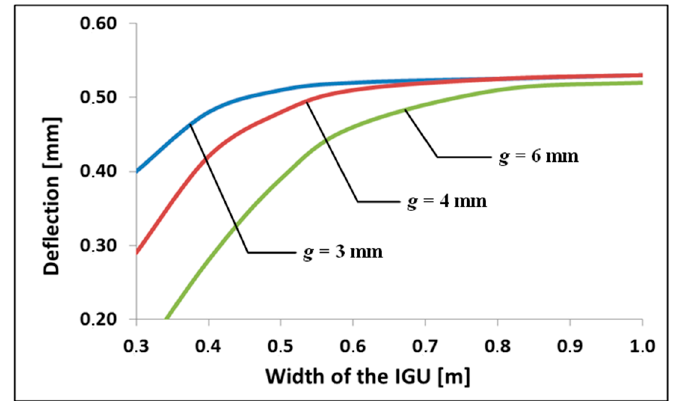
Figure 5. Dependence of the deflection of component glass panes w c on the width of the IGU (atmospheric pressure increase of ∆ p = 3 kPa).